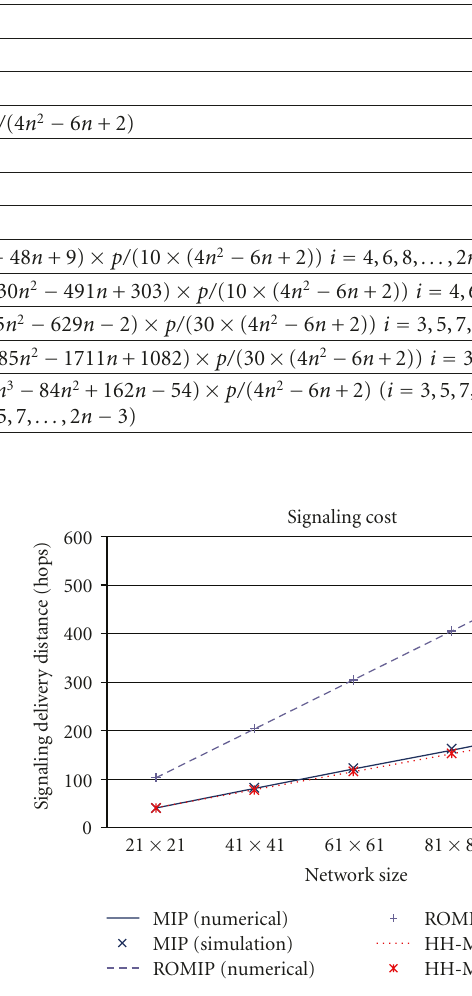
Figure 11: Comparison of signaling cost between di ff erent